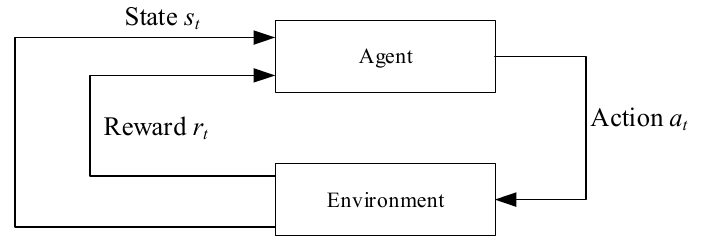
Figure 4. Fundamentals of reinforcement learning.